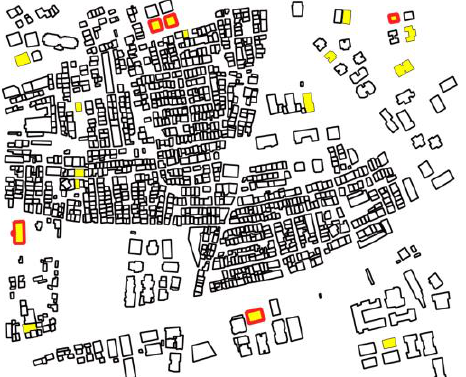
Figure 10. Detection of collapsed buildings(yellow), reds are the ground truth.